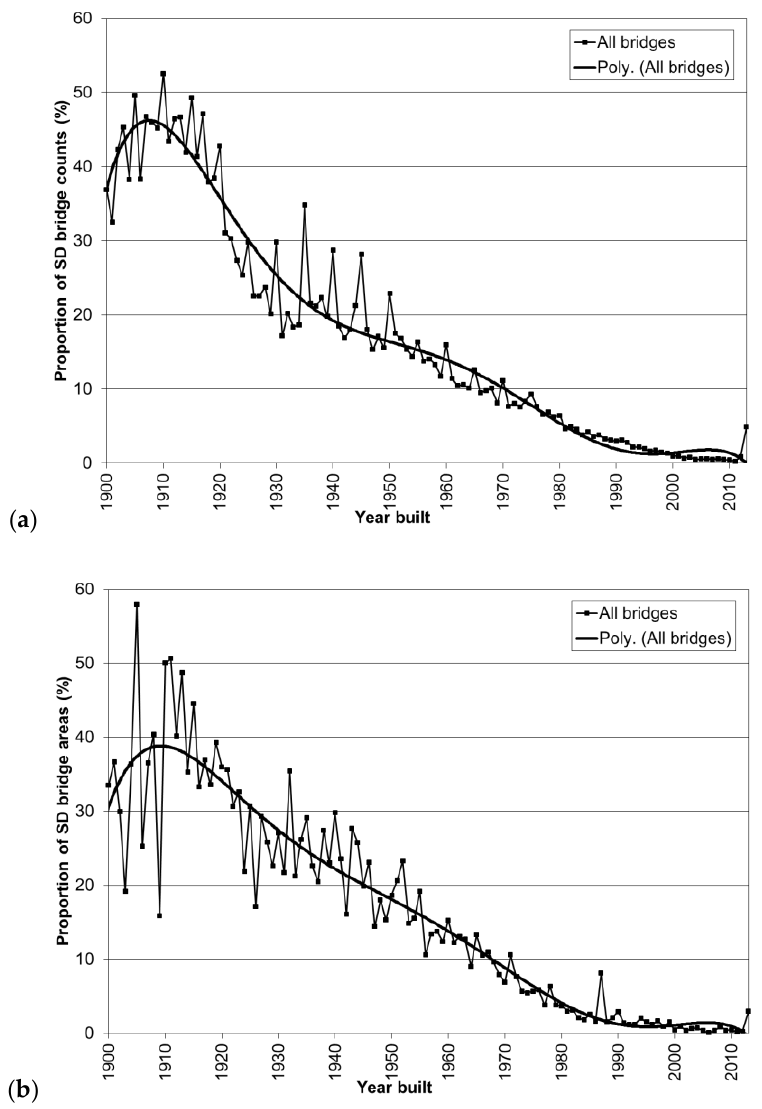
Figure 10. Distribution of the proportion of all SD bridges. (a) Counts. (b) Areas.